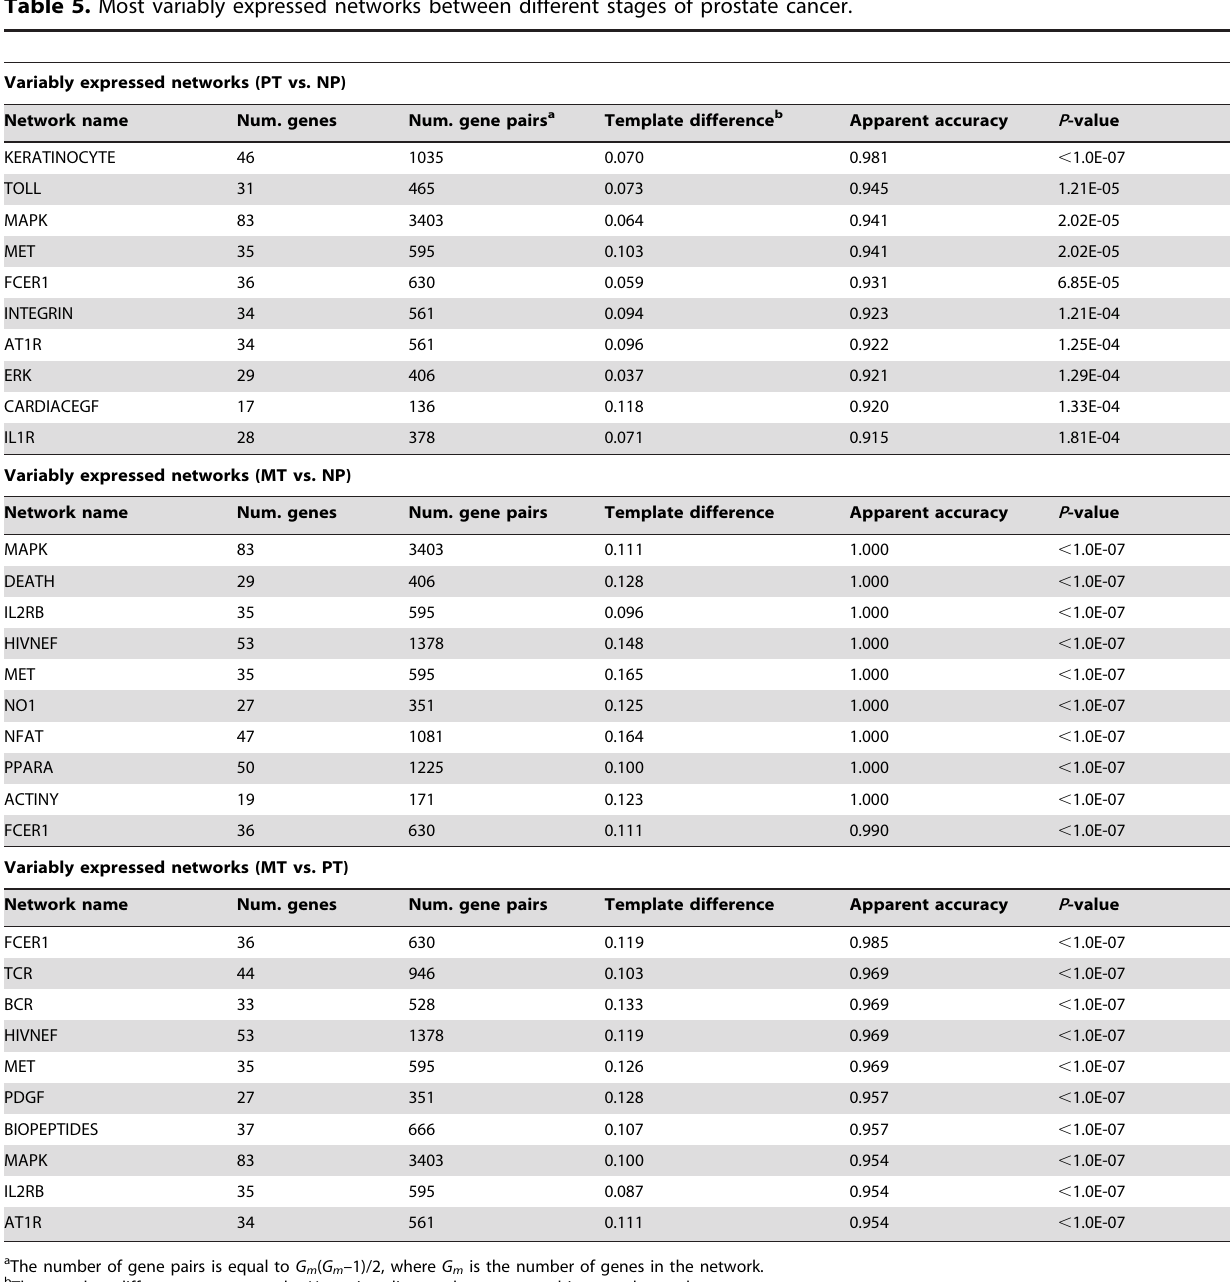
Table 5. Most variably expressed networks between different stages of prostate cancer.